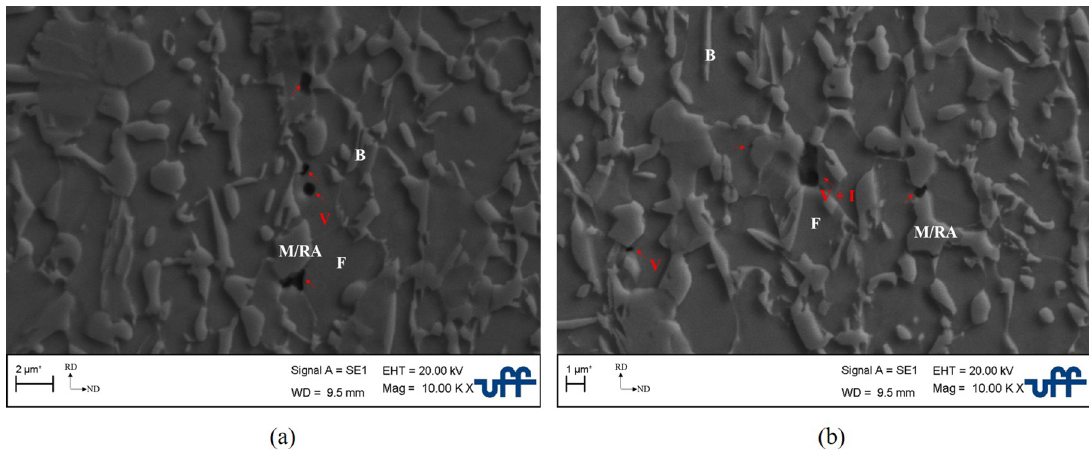
Figure 9. Scanning electron microscopy images obtained from the TRIP780 steel sheet uniaxial samples deformed at (a) 15% (10000×) and (b) 18% (10000×) of total strain. The micrographs were taken at regions cut parallel to the sheet rolling direction, i.e., along the major strain axis. The letters B, F, M/RA, V and I designate ferrite, martensite/retained austenite, void and inclusion,